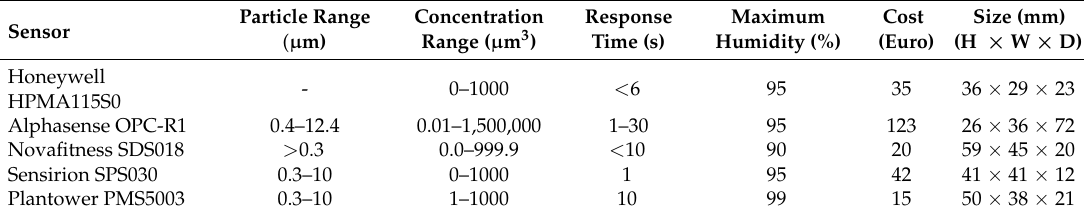
Table 1. Manufacturer specifications of the five models of low-cost particulate matter (PM) sensors